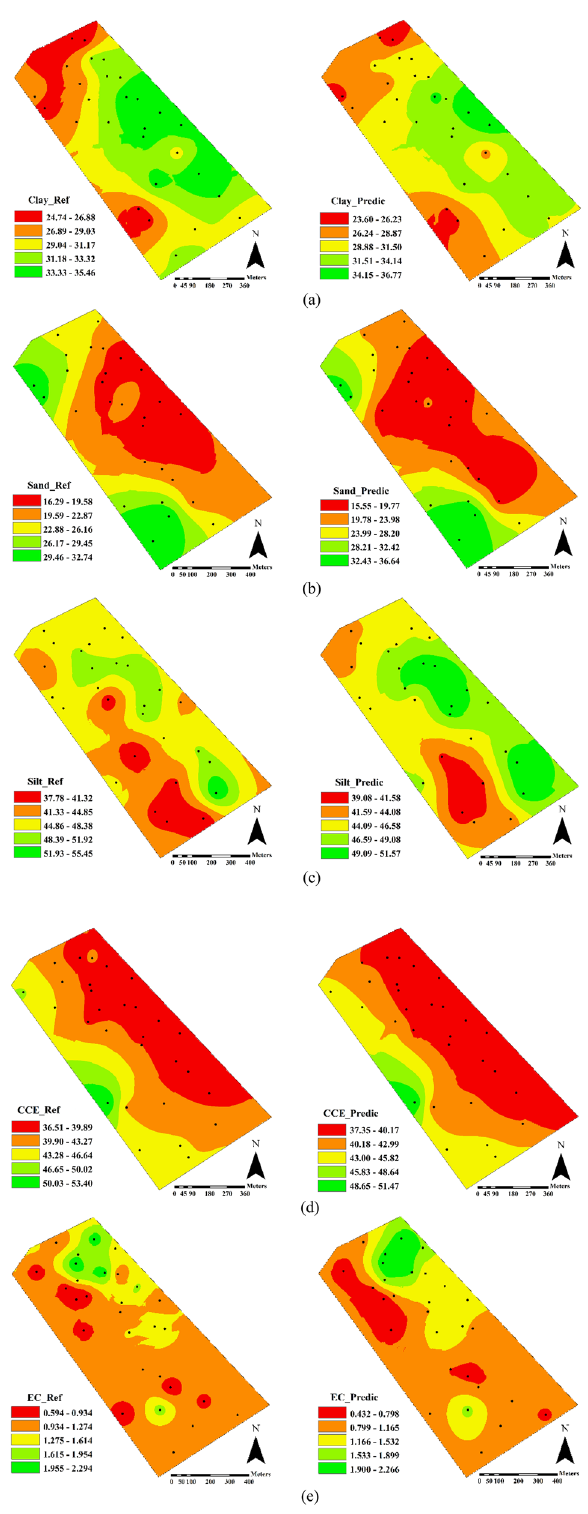
Figure 6. Field-scale spatial variation maps of reference and estimated values of ( a ) clay, ( b ) sand, ( c ) silt, ( d ) calcium carbonate equivalent (CCE), and ( e ) electrical conductivity (EC), obtained from best predictive models with optimum spectral